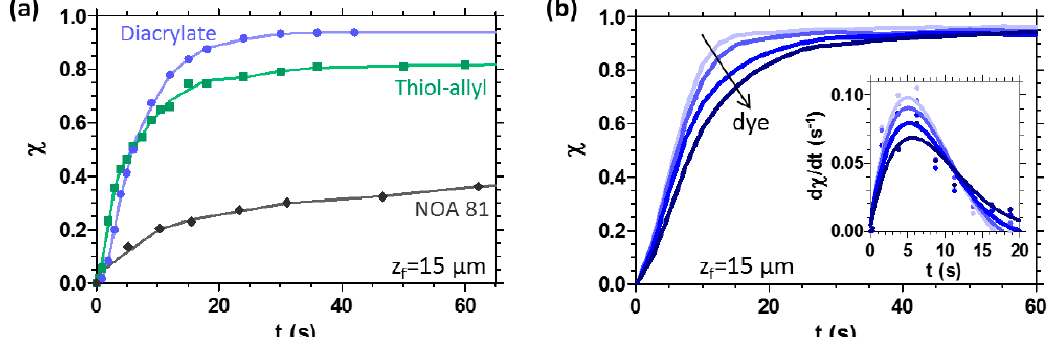
Figure 3. ( a ) Conversion χ as a function of exposure time t , for acrylic and thiol-ene systems, measured by FT-IR spectroscopy on 15 μ m thick films, photopolymerised by using a light intensity I = 28 W·m − 2 ; ( b ) influence of the dye on the photopolymerisation reaction kinetics, for diacrylate system (film thickness z f = 15 μ m). The absorbing dye was added in the range 0–0.25 wt %. The inset reports the first derivative of the conversion, which is an indication of the reaction rate.